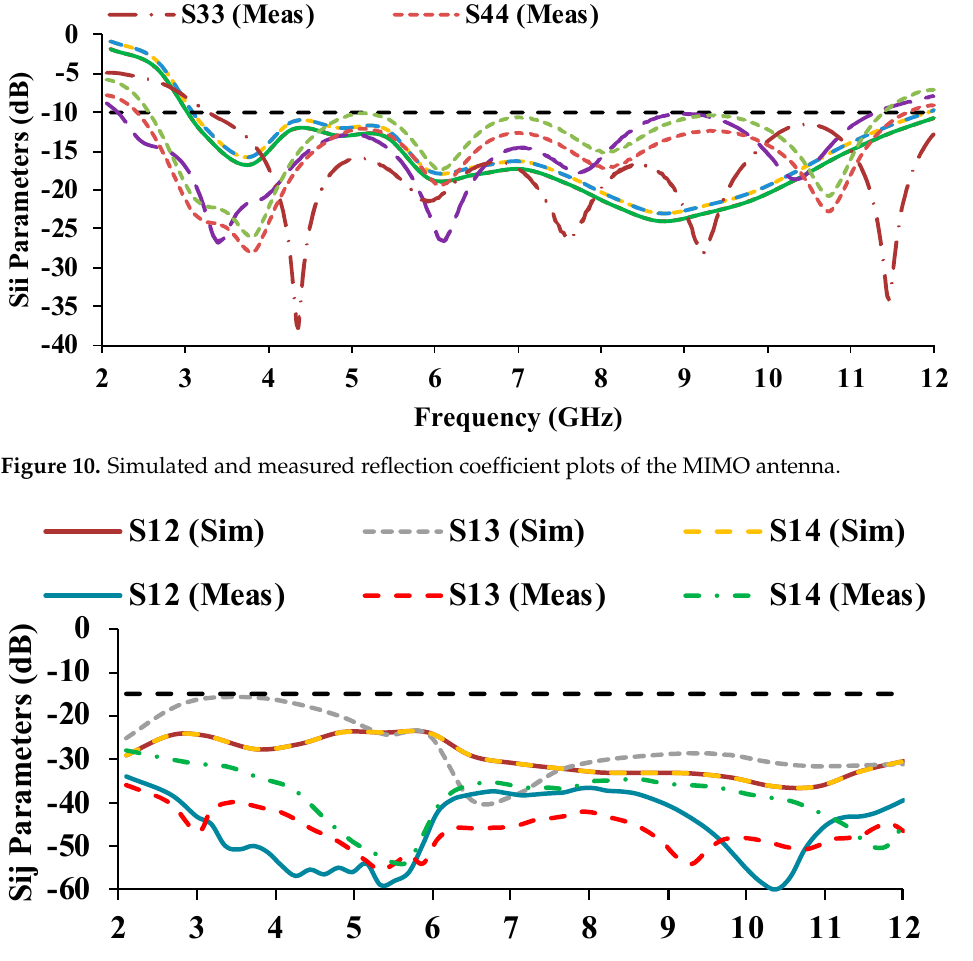
Figure 11. Simulated and measured mutual coupling plots of the MIMO antenna. over the entire UWB